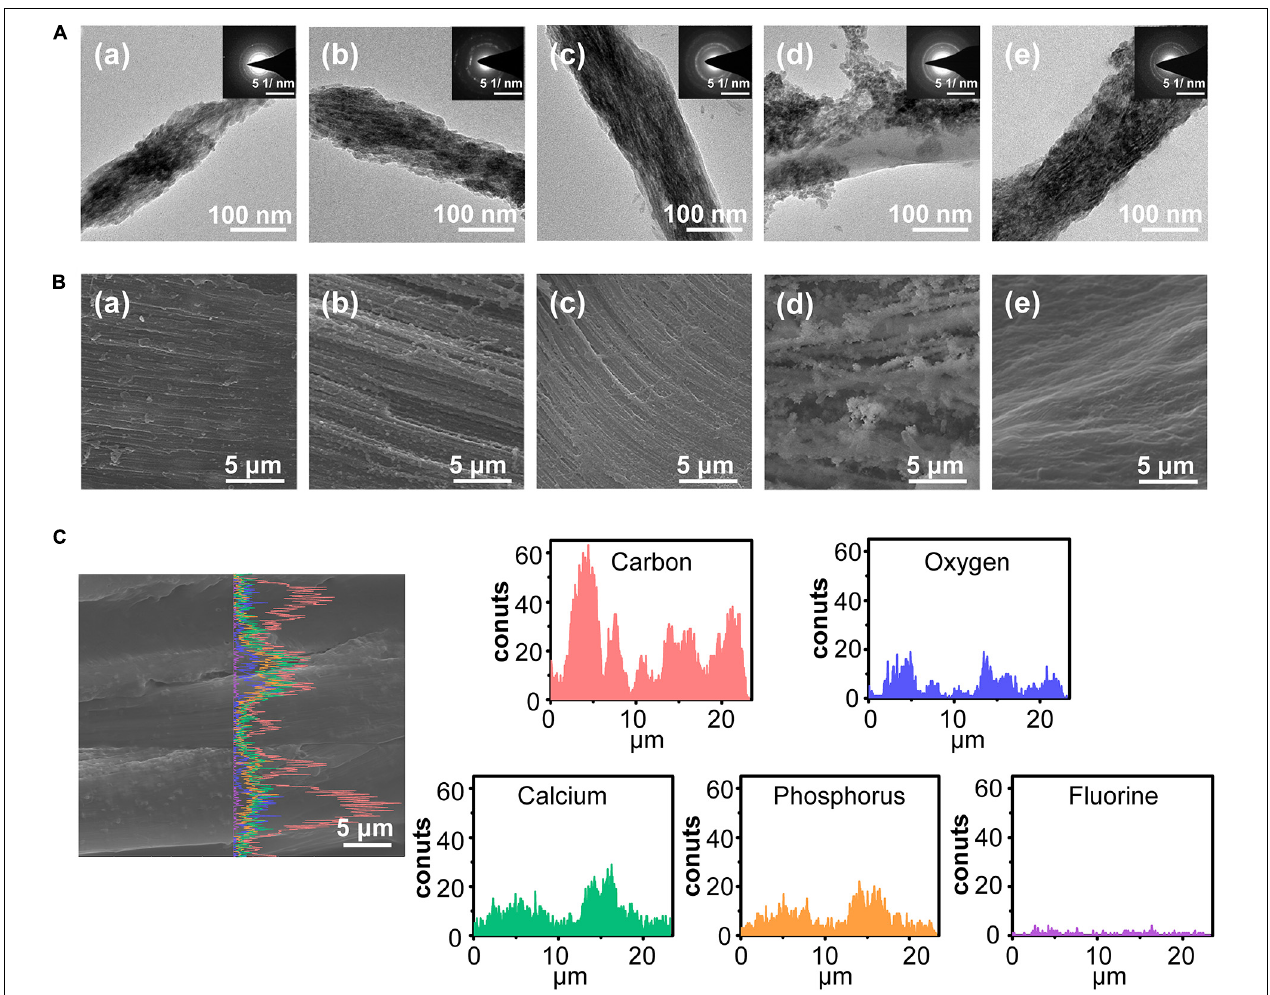
FIGURE 4 | The morphology of biomimetic cementum. (A) TEM images and the corresponding SAED pattern of biomimetic cementum. (B) The surface view of SEM image. (a–d) indicated 0.625, 1.25, 2.5, and 5 mM group of biomimetic cementum, respectively. (e) Cementum. (C) The SEM images with corresponding EDS line scanning along the longitudinal section of 2.5 mM biomimetic